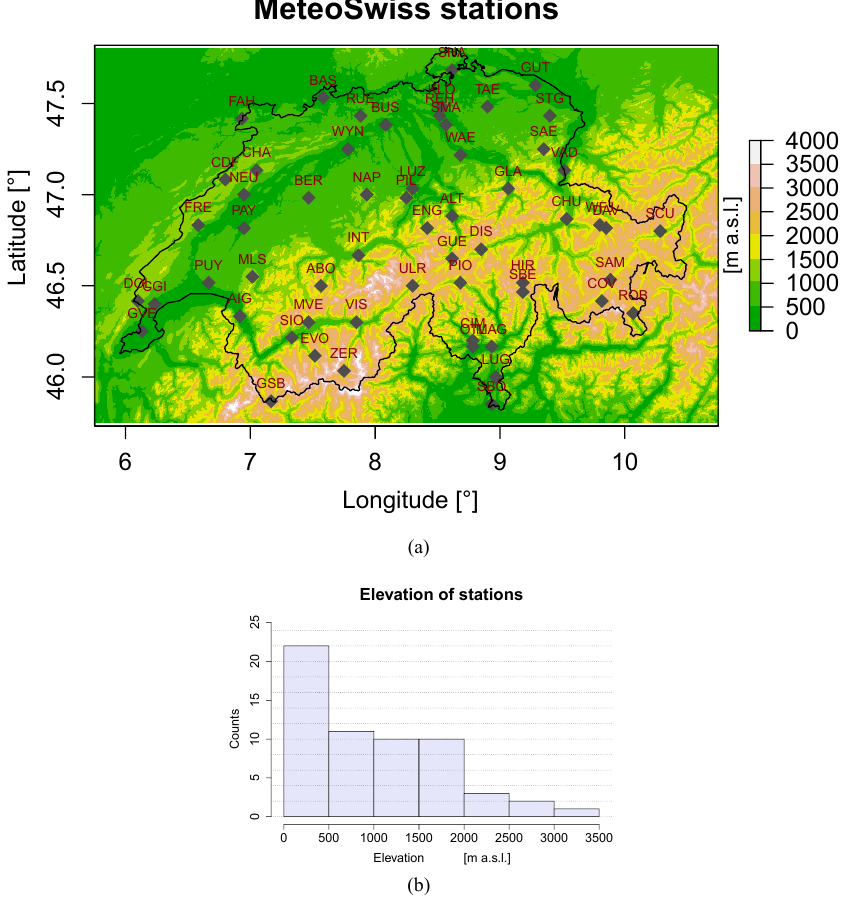
Figure 1. (a) Orography of the study area including the Swiss Alps, according to a 500m resolution digital elevation model. Automatic meteorological stations of the MeteoSwiss network providing at least 80% of valid daily total precipitation data over the period 1981–2010 are labeled with gray diamonds. (b) Distribution of the elevations of the MeteoSwiss stations grouped in 500m elevation